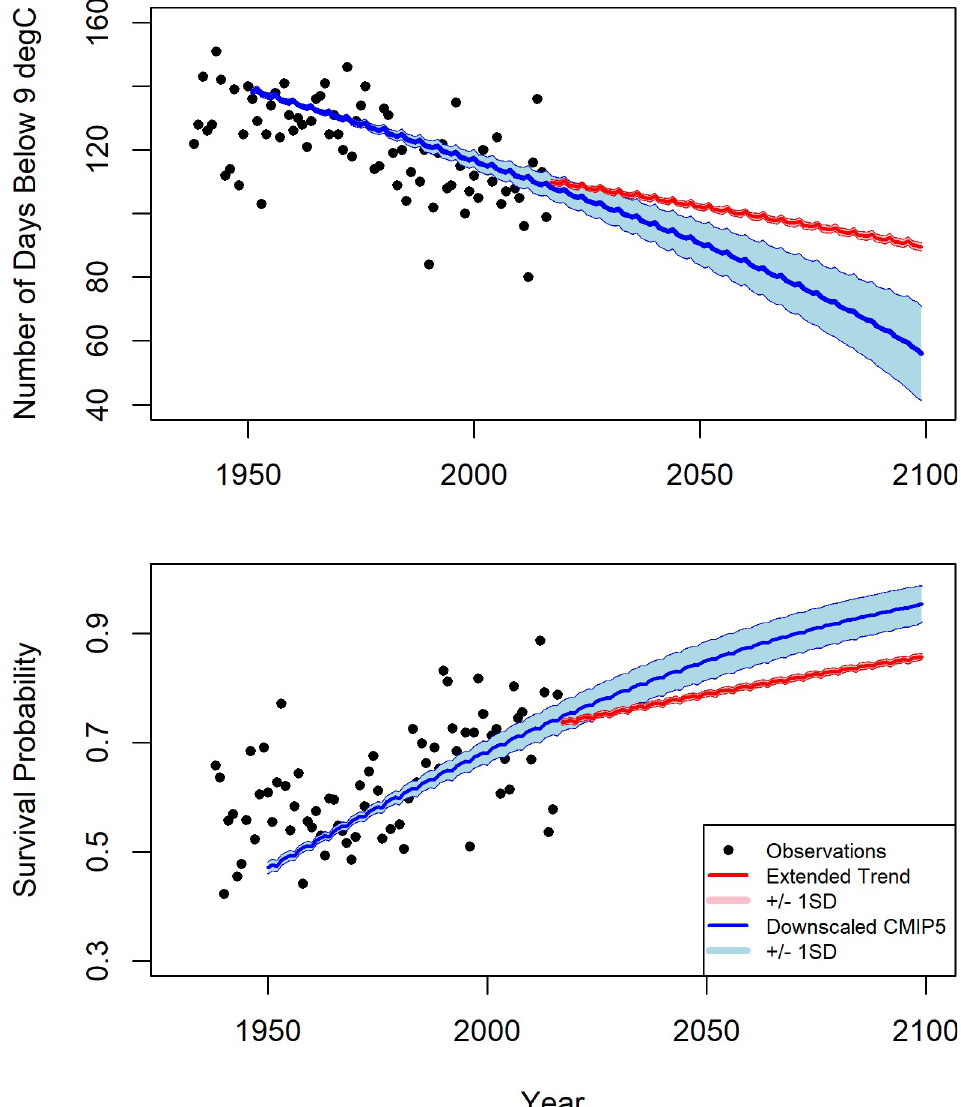
Fig 3. Length of crab overwintering period (top panel; expressed as the number of days below 9˚C in a given year) and probability of overwinter survival (bottom panel) for observational data (black dots) and projected data from two sources (conservative estimate (Extended Trend) in red and a multi-model ensemble of downscaled GCM data (Downscaled GCM) in blue). The year 1977 was excluded from the analysis due to large gaps in the observational data for that year. Error bands for projections represent one standard